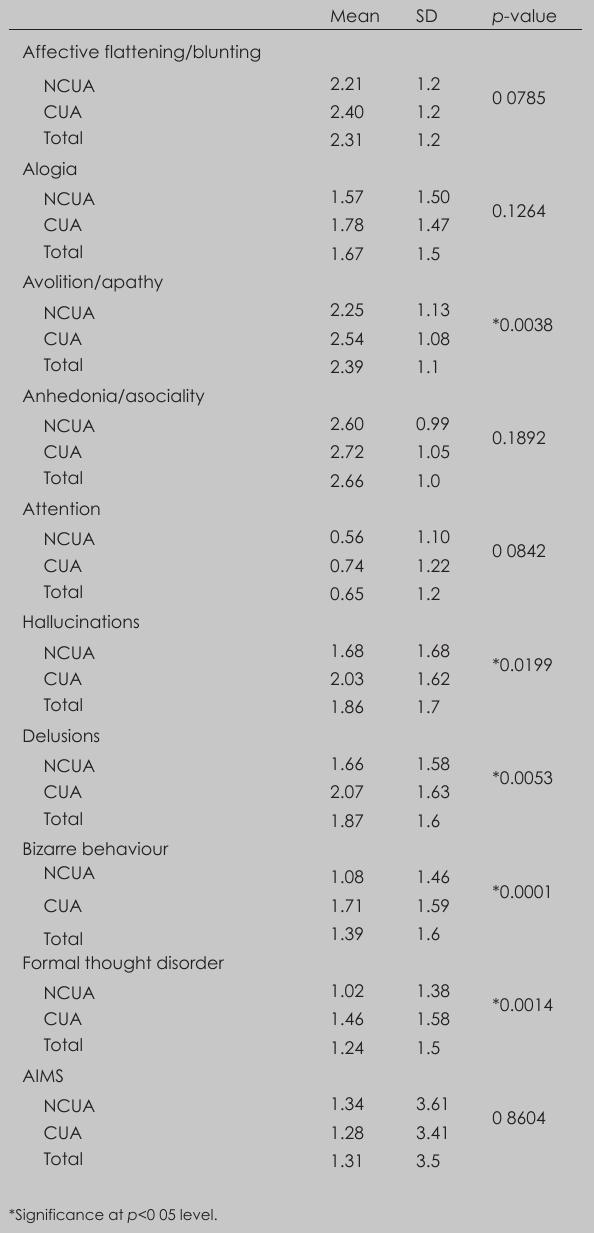
Table IV. Comparison between CUA and NCAU groups with reference to SAPS and SANS subscores and AIMS total